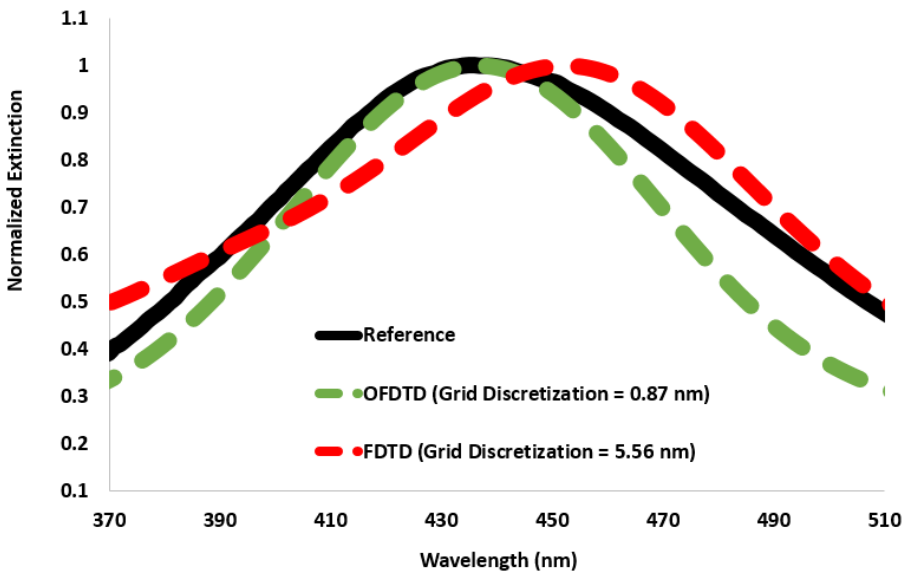
Figure 3. Normalized extinction spectra: comparison of FDTD and OFDTD results. The results were also compared with the experimental reference results for validation purposes.